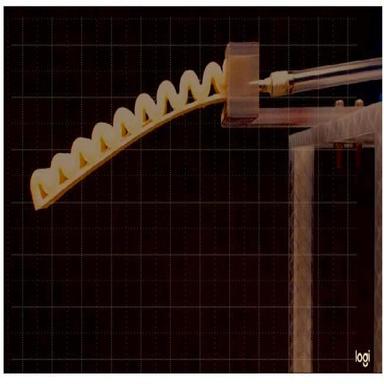
Experimental test setup.